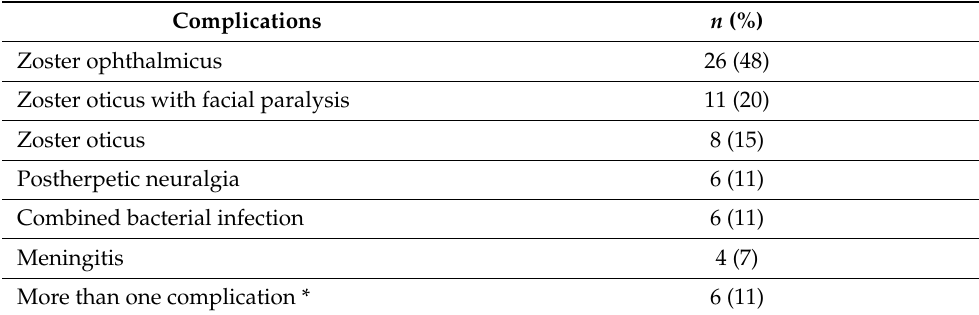
Table 2. Types of complications ( n =